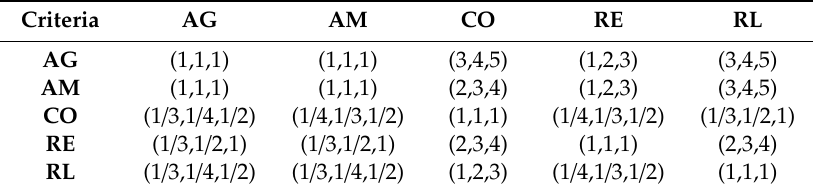
Table 2. The fuzzy comparison matrices for the goal.